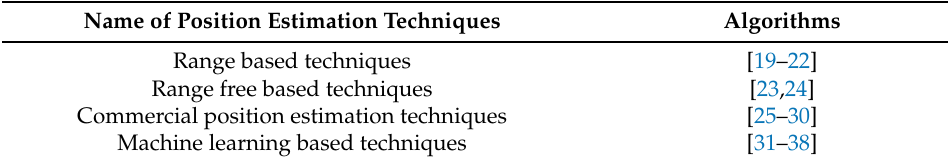
Table 1. Position estimation